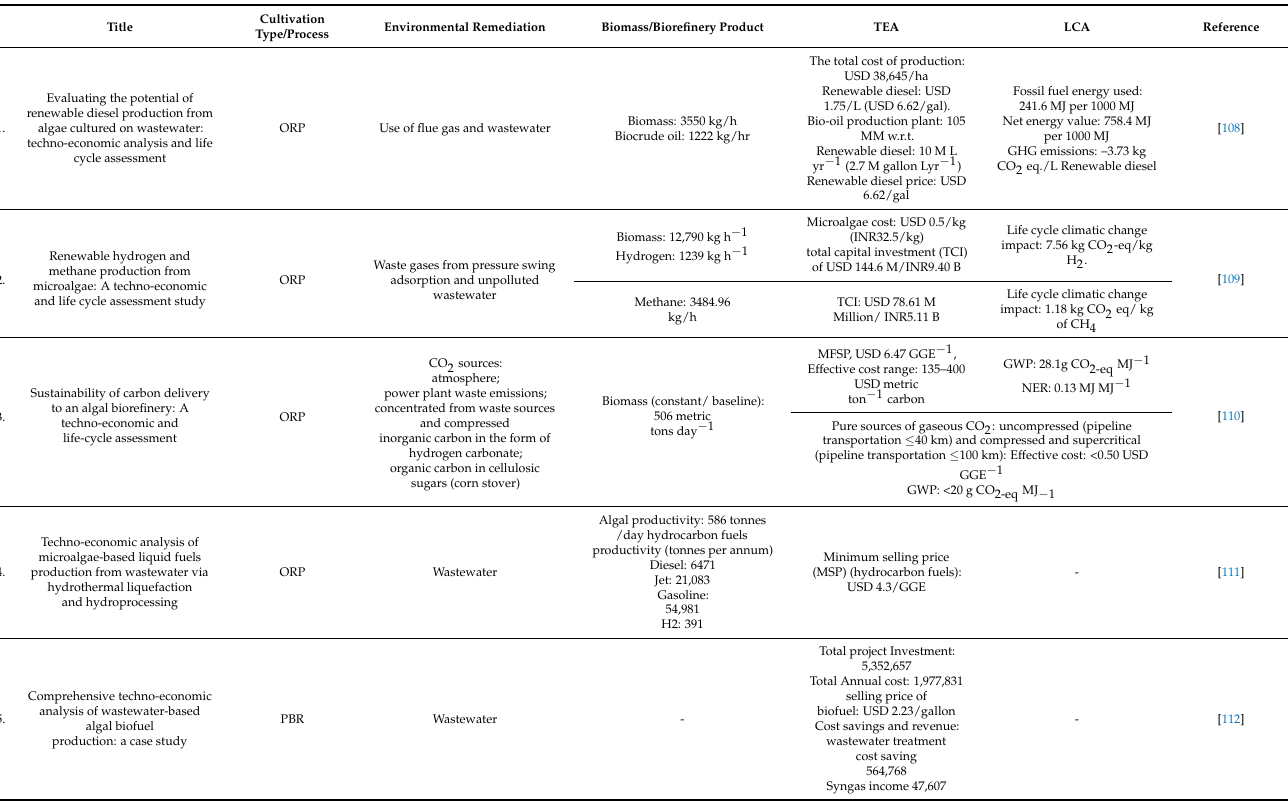
Table 3. The techno-economic analysis and life cycle assessment of bioremediation integrated microalgal cultivation processes biorefinery